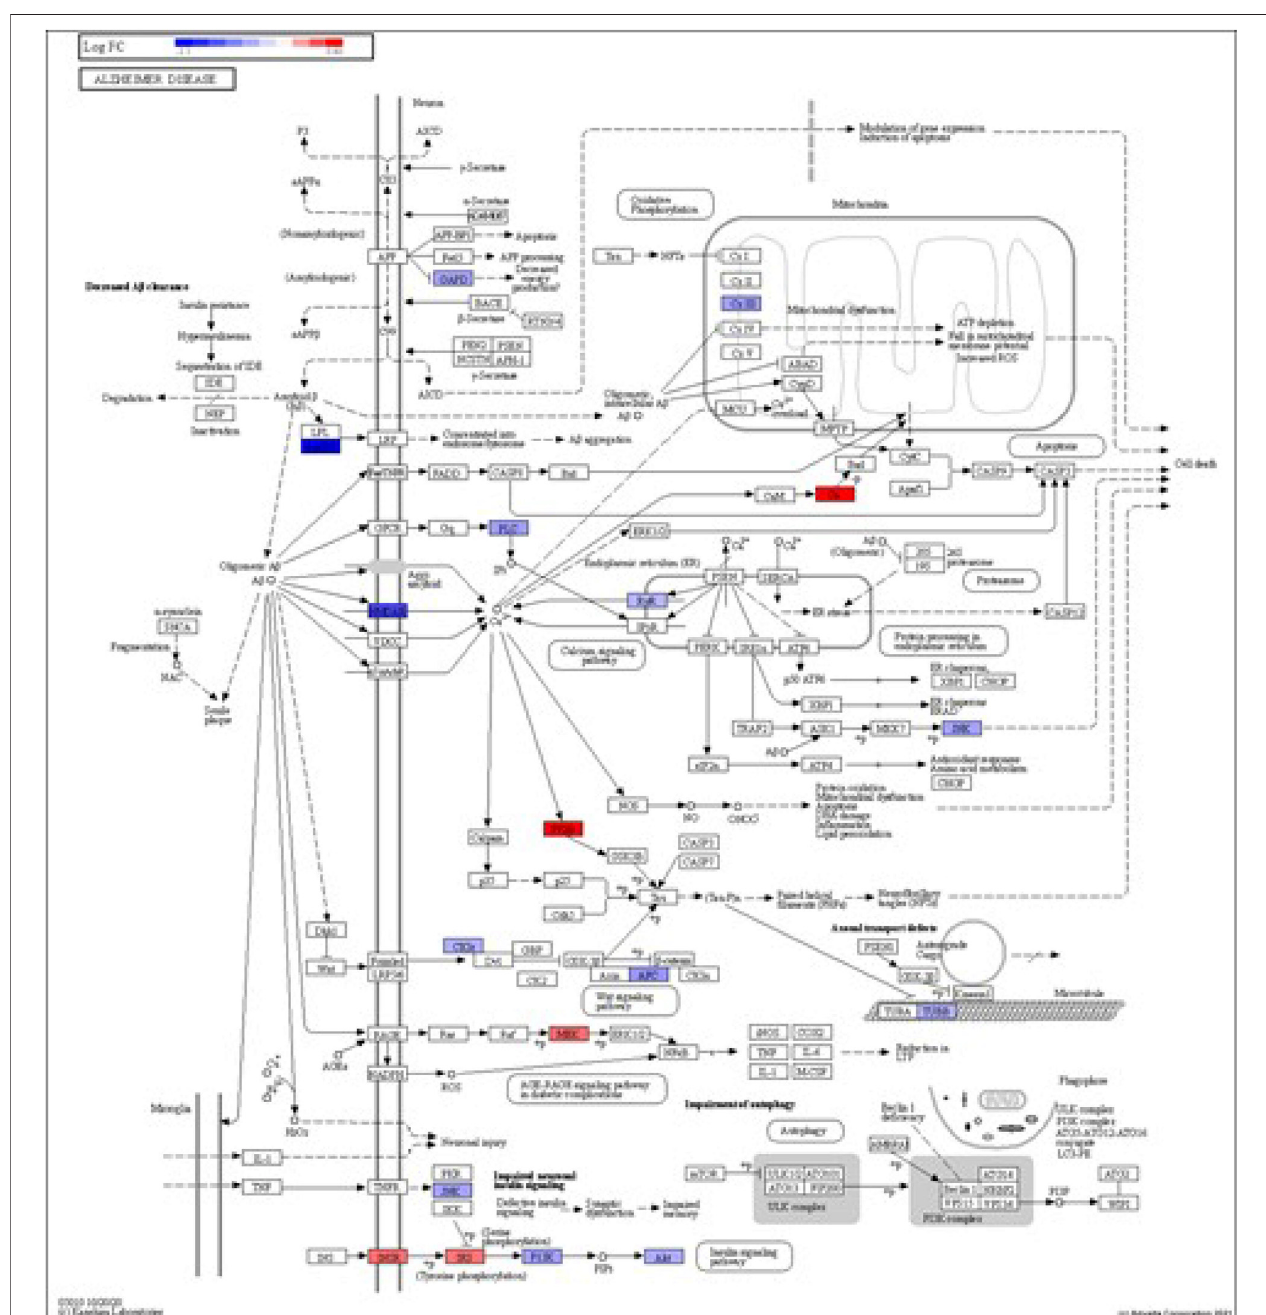
FIGURE5| iPathwayGuideanalysisshowsthedifferentiallyregulatedgenesintheKEGGAlzheimer ’ sdiseasepathwayinastrocytesfromtheADgroup(AD00206) compared to astrocytes from the healthy control group (AD00201).